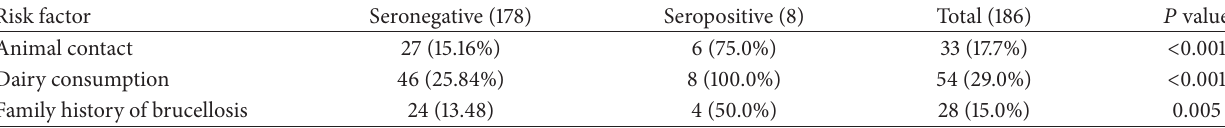
Table 1: Distribution of risk factors for disease in children based on serological test result.